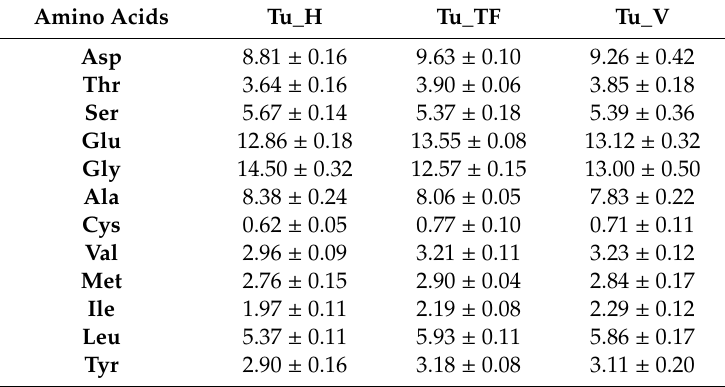
Table 3. Amino acids content of fish protein hydrolysates (FPHs) (% or g / 100 g total amino acids) from turbot by-products. OHPro: hydroxyproline. Pr: protein concentration calculated in g / L as the total sum of amino acids present in FPH. TEAA / TAA: ratio total essential amino acids for human / total amino acids. Errors are the confidence intervals for n = 10 (replicates of independent hydrolysates) and α =